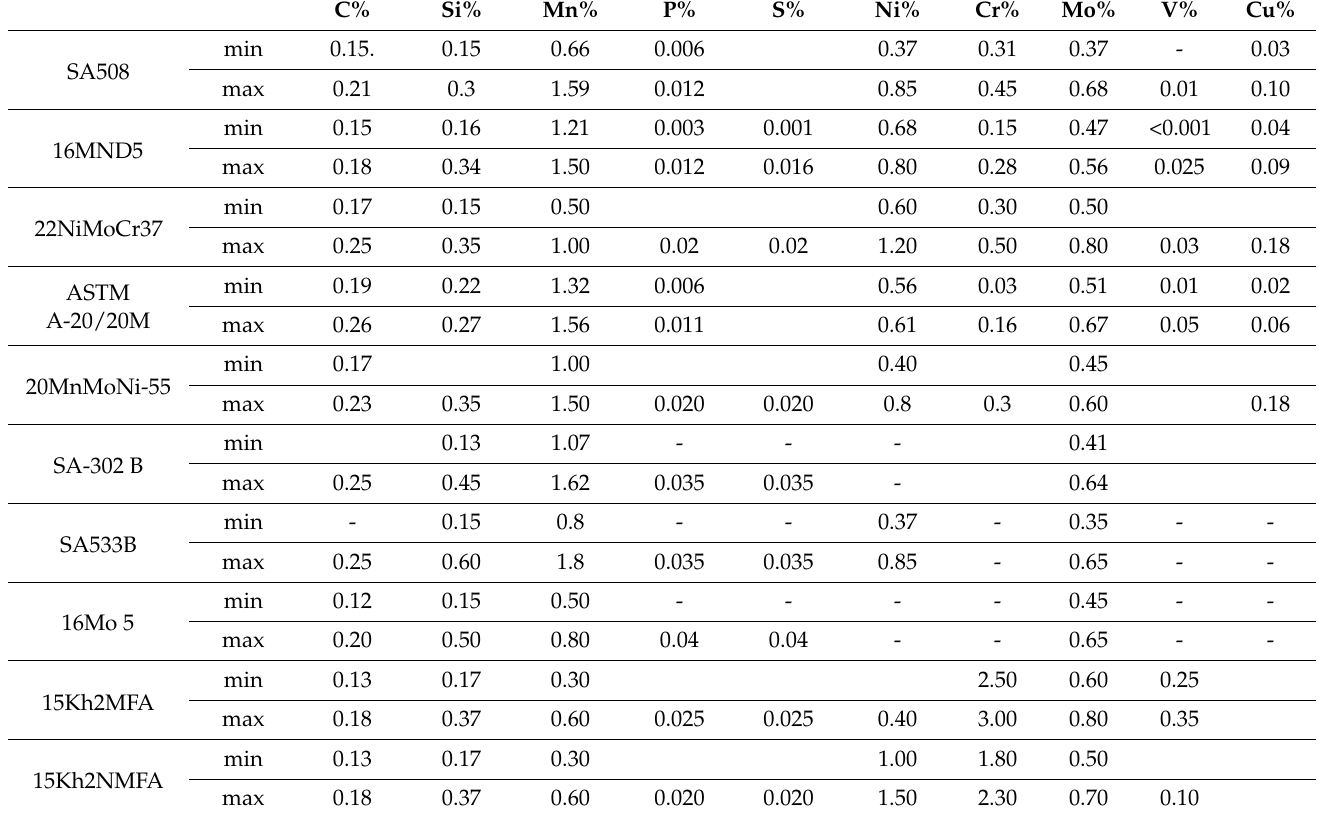
Table 1. The chemical composition of low alloyed steels used for pressurized water reactor pressure